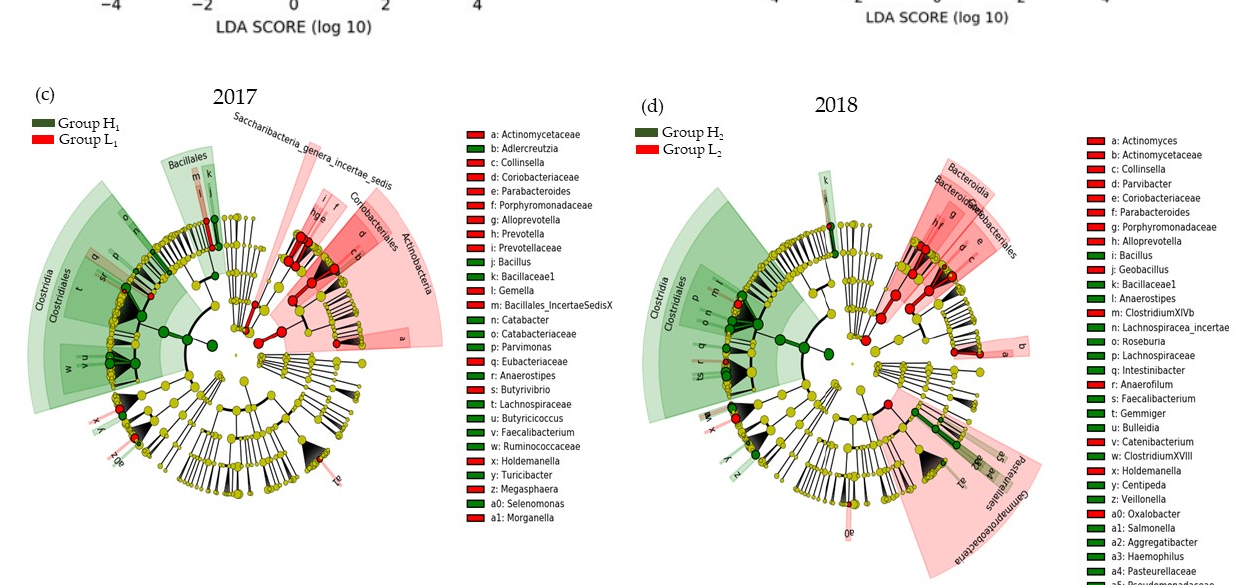
Figure 5. The LEfSe results of high- and low-intake groups of water-soluble dietary fiber: ( a ) The linear discriminant analysis in 2017; ( b ) The linear discriminant analysis in 2018; ( c ) The cladogram report in 2017; ( d ) The cladogram report 2018. Group L 1 : Water-soluble dietary fiber intake < 2.62 g/day in 2017; Group H 1 : Water-soluble dietary fiber intake ≥ 2.62 g/day in 2017; Group L 2 : Water-soluble dietary fiber intake < 2.66 g/day in 2018; Group H 2 : Water-soluble dietary fiber intake ≥ 2.66 g/day in 2018.